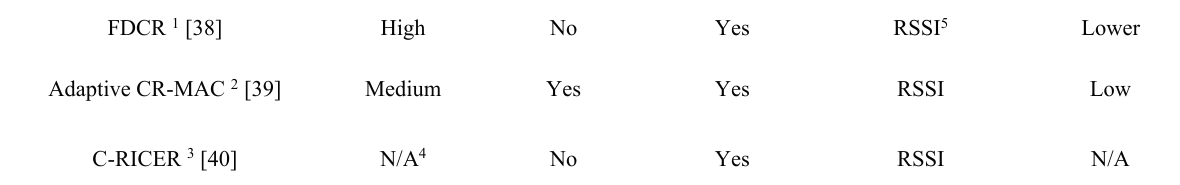
Table 3. Comparison of the interference mitigation schemes in the cognitive radio approach. Interference Mitigation